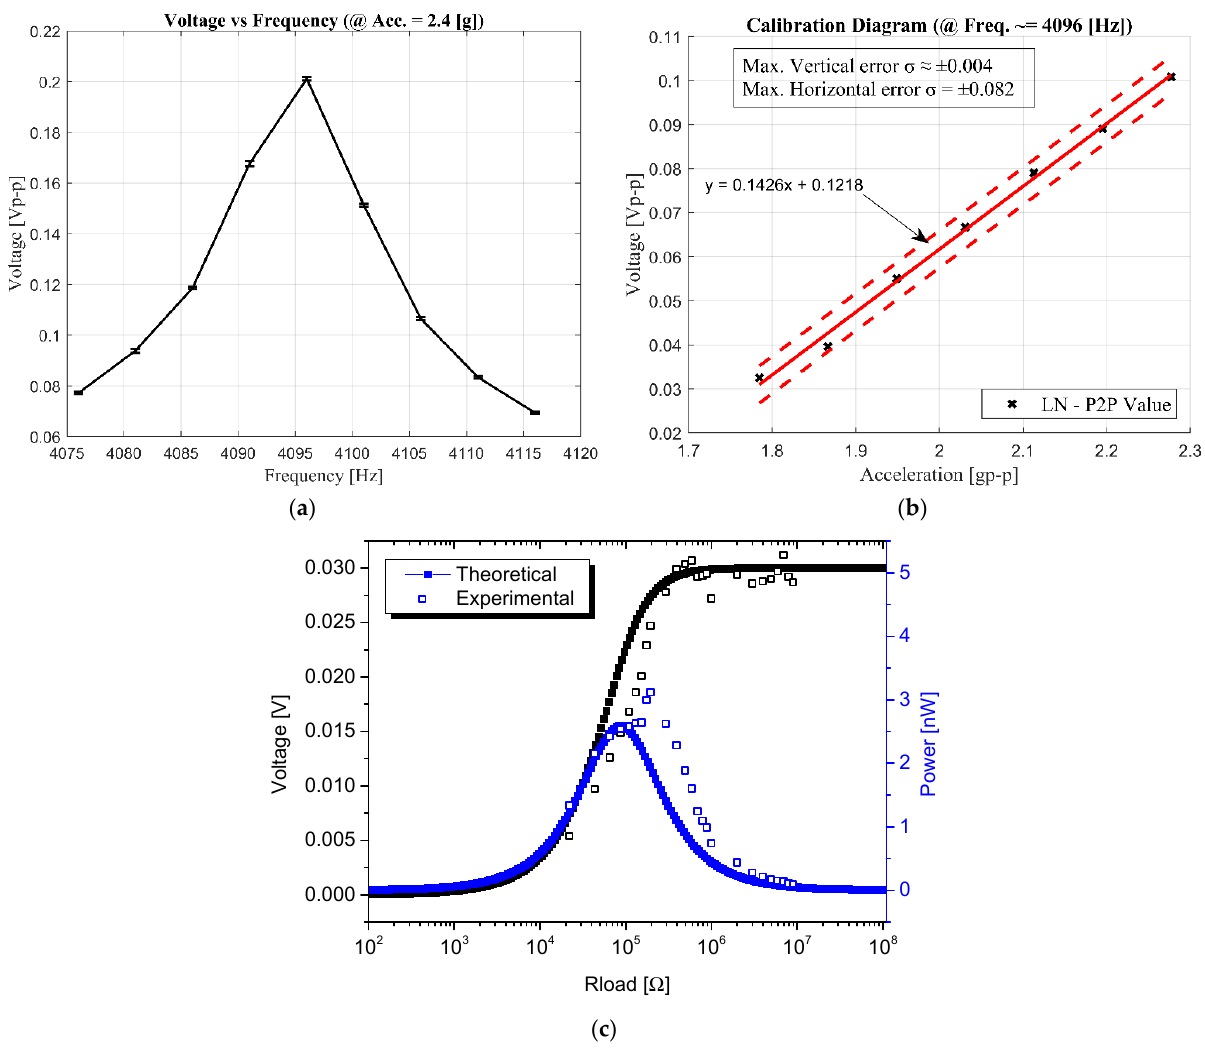
Figure 8. Characterization results of the device: ( a ) voltage vs. frequency ( b ) voltage vs. acceleration–calibration diagram ( c ) Power and voltage output comparison for the simulated and experimental results.